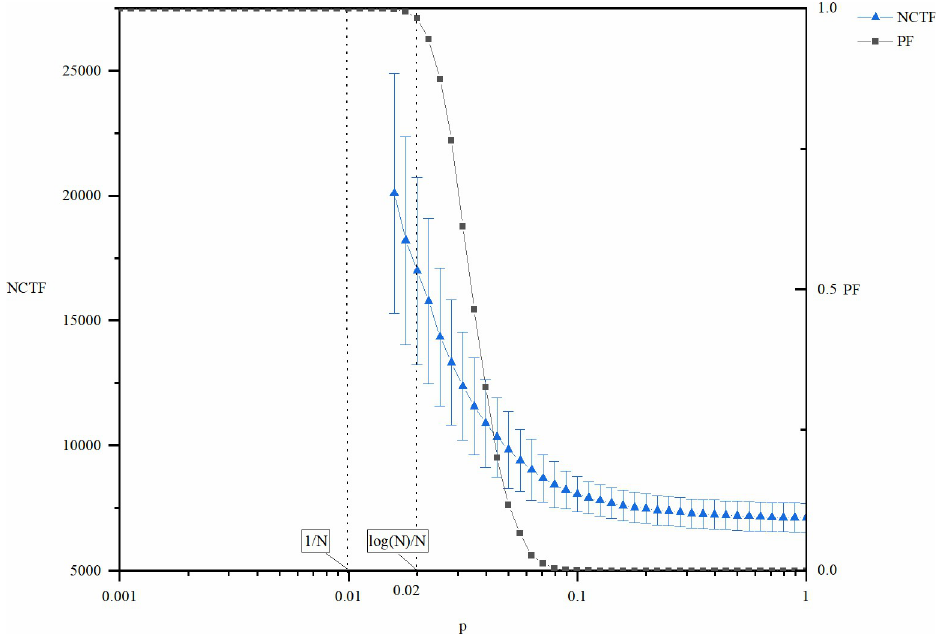
Fig 1. NCTF and PF of explorative innovation as a function of